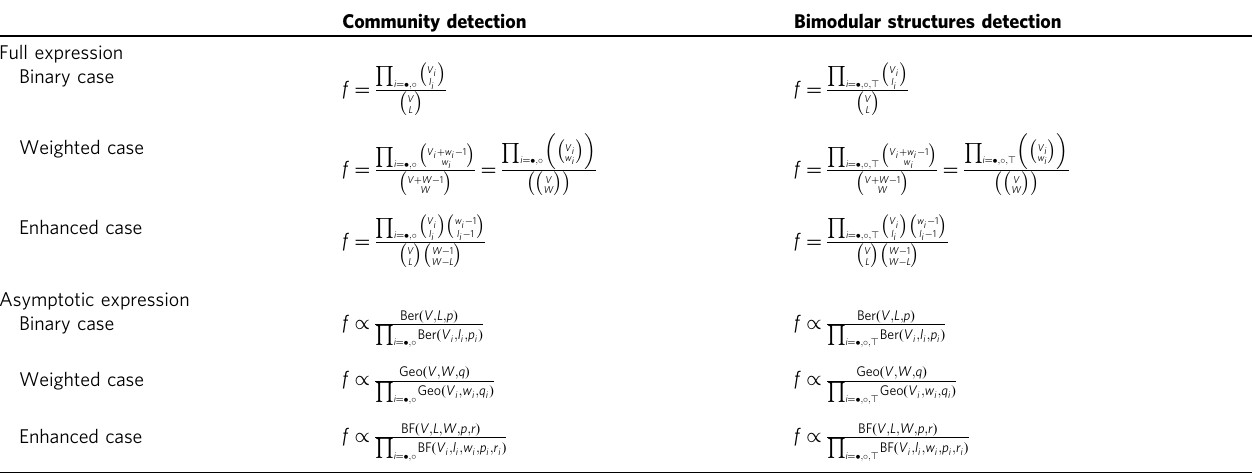
Fig. 4: while the performance of modularity starts decreasing as soon as the value of μ t is risen and NMI Infomap ≃ 0 when μ t crosses the value of 0.6, the performance of surprise degrades much more slowly - in fact, for some instances of the LFR benchmark, it achieves a large value of NMI even for values μ t ≥ 0.8.